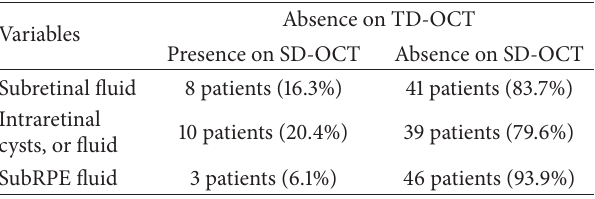
Table 1: The findings on spectral-domain optical coherence tomog- raphy when time-domain optical coherence tomography and clin- ical examination showed no sign of choroidal neovascularization activation.